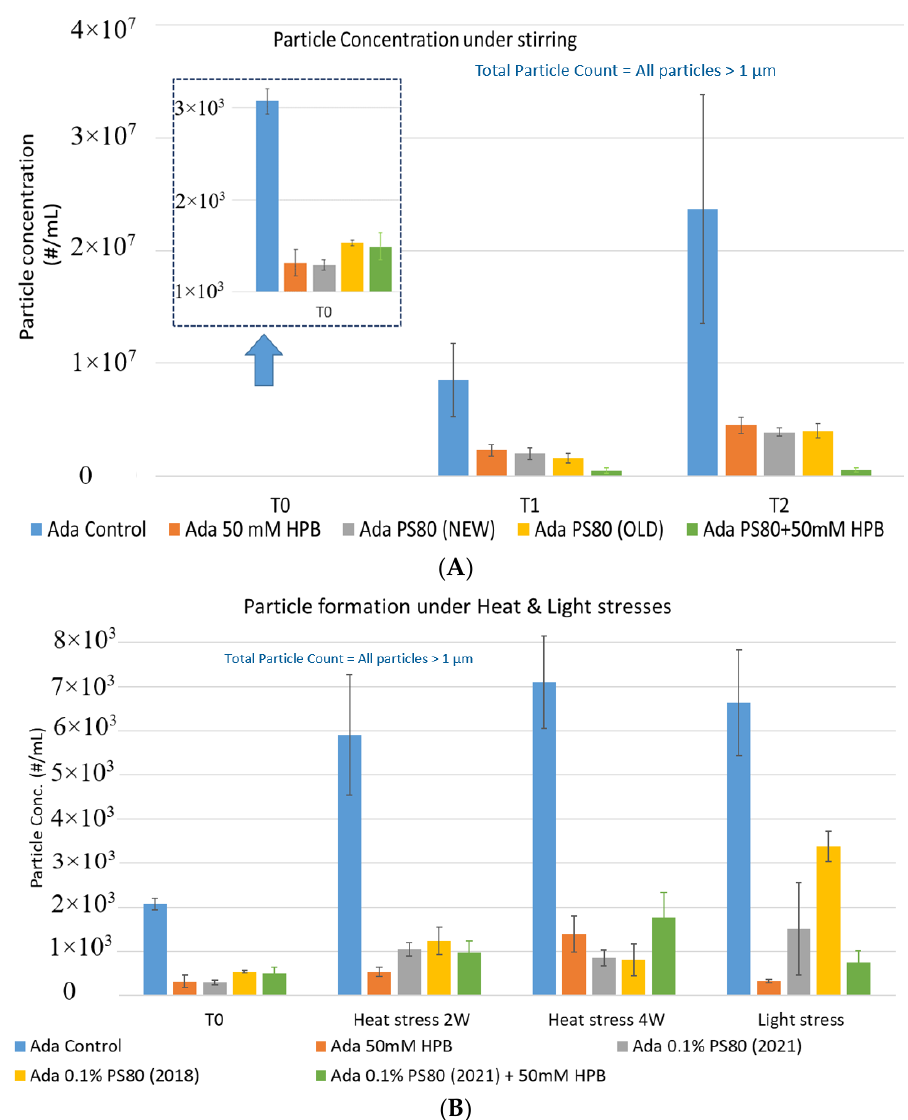
Figure 8. Particle formation with adalimumab in different formulations under stirring ( A ) and thermal and light stress ( B ).